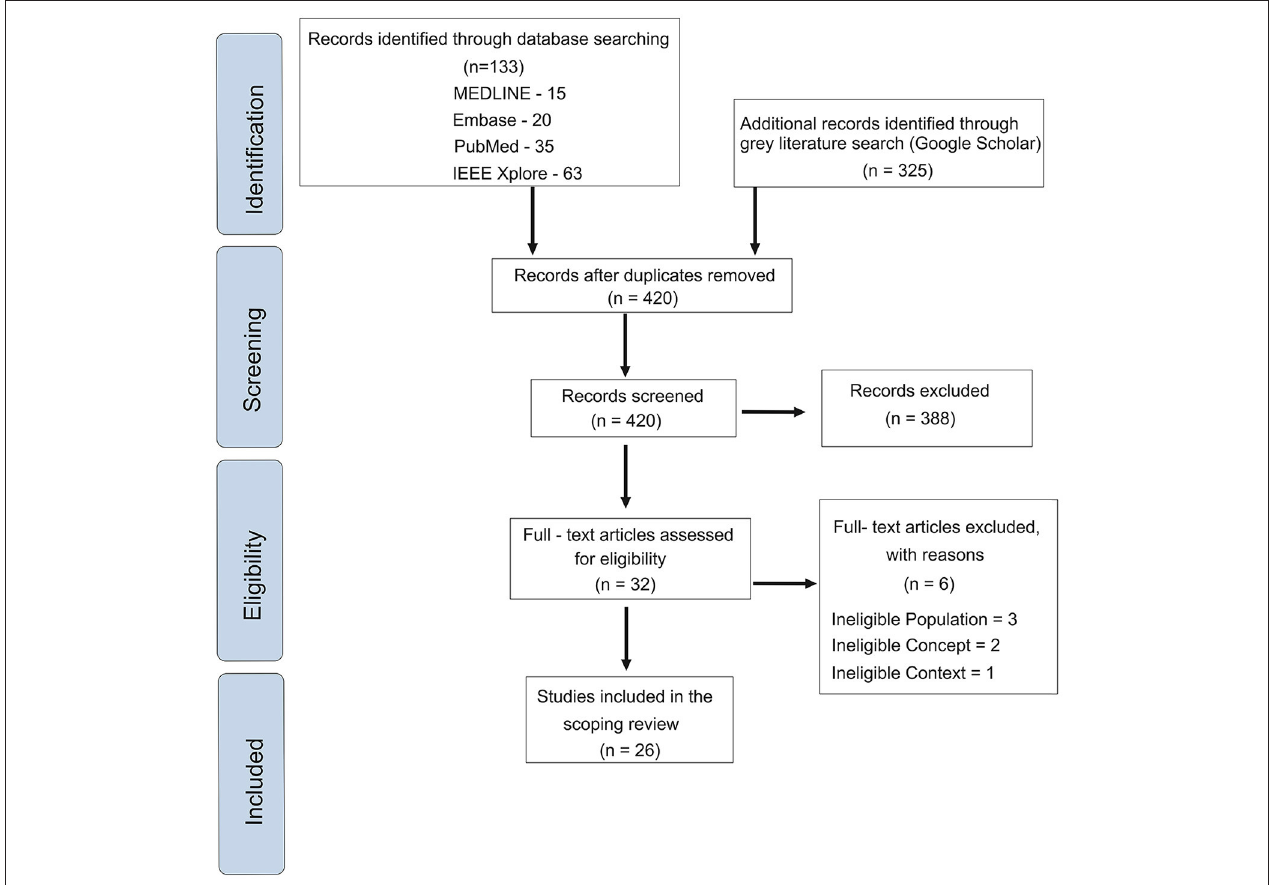
FIGURE 1 | Workflow of the scoping